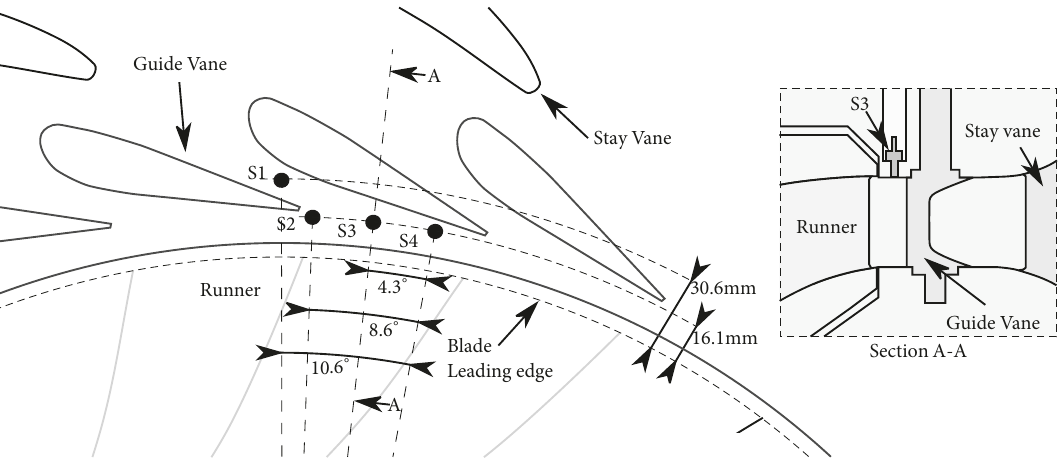
Figure 4: Pressure sensors in the vaneless space and in the guide vane cascade. The angular distance between sensor S2-S3 and S3-S4 is 4.3 ∘ . The sensors were flush mounted in the upper cover of the turbine as shown with sensor S3 in section A-A. The distances from the runner blades leading edges to the sensors are 16.1mm and